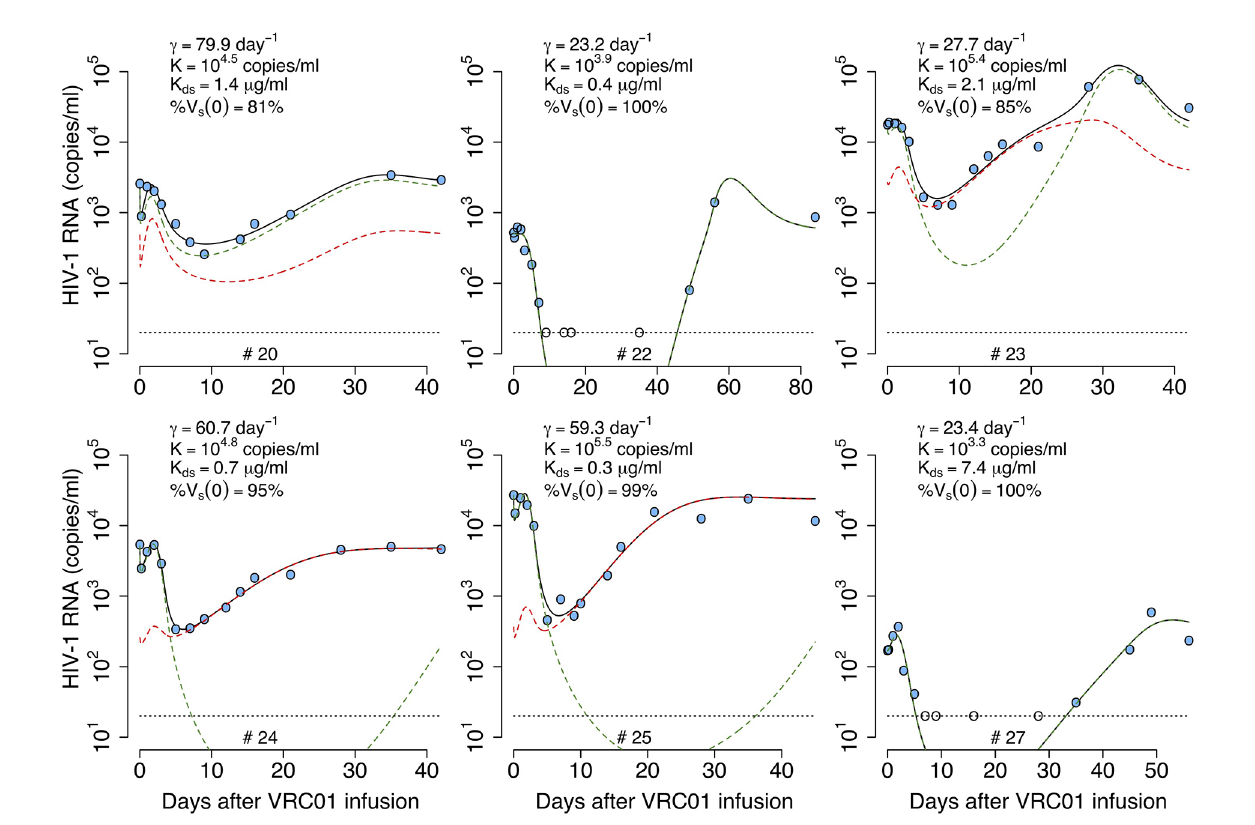
FIGURE 10 | Best- fi ts of the two viral population phagocytosis-based logistic clearance model, equation (20), to viral load data from participants receiving a single infusion of VRC01. Blue- fi lled and un fi lled circles are the HIV-RNA over and below the limit of detection, respectively. Solid black lines are the best- fi t of the model, ( V s + V r + C s + C r ) in equation (20) to the data. Green and red dashed lines show the sensitive ( V s + C s ) and less sensitive ( V r + C r ) virus concentration prediction of the model, respectively. Relevant parameter estimates for each participant are shown in each plot and all parameter estimates are given in Table S7 . Fixed parameter values are described in Table 1 . Other parameters and initial values were derived by assuming the system was in steady state before VRC01